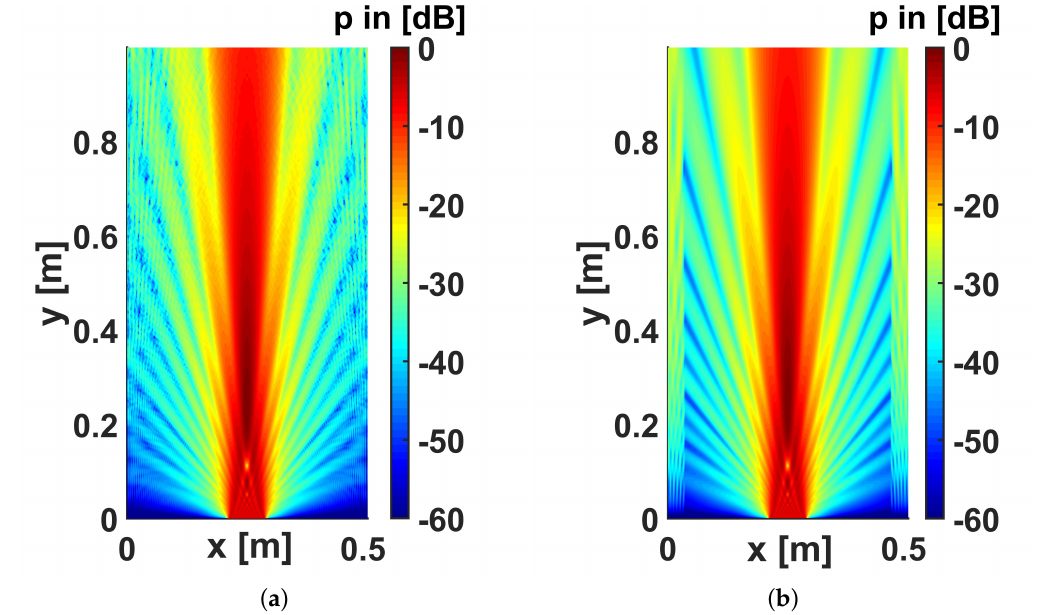
Figure 20. Amplitude distribution of the idealized circular piston transducer after forward propagation with the ( a ) spec-radiation method and ( b ) the re-radiation method. Normalized to the maximum in the volume. Scaled to − 60